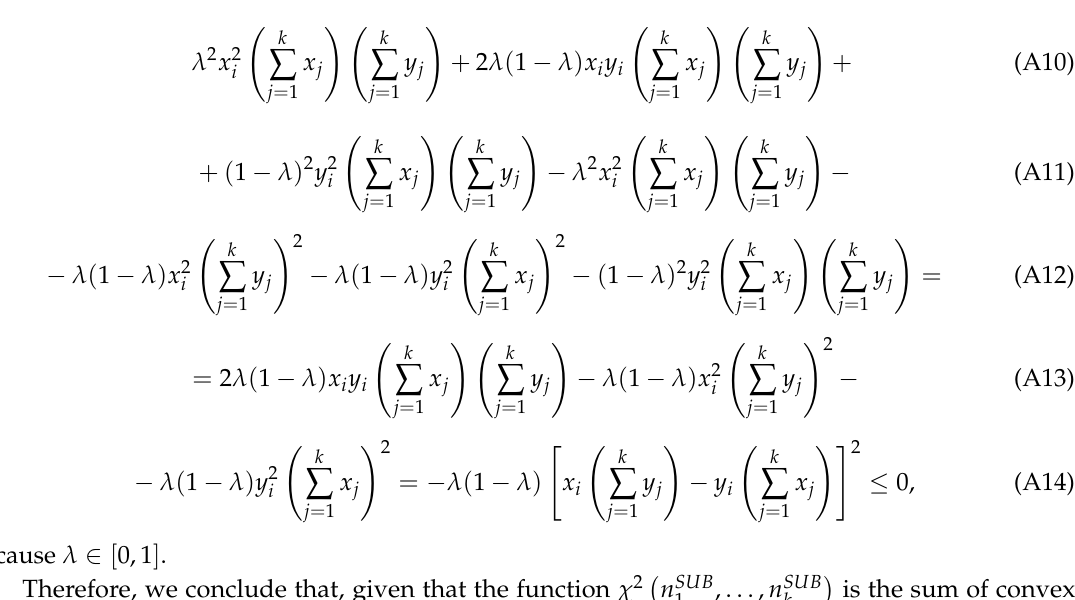
) for non-negative values of ( n SUB , n SUB 2 1